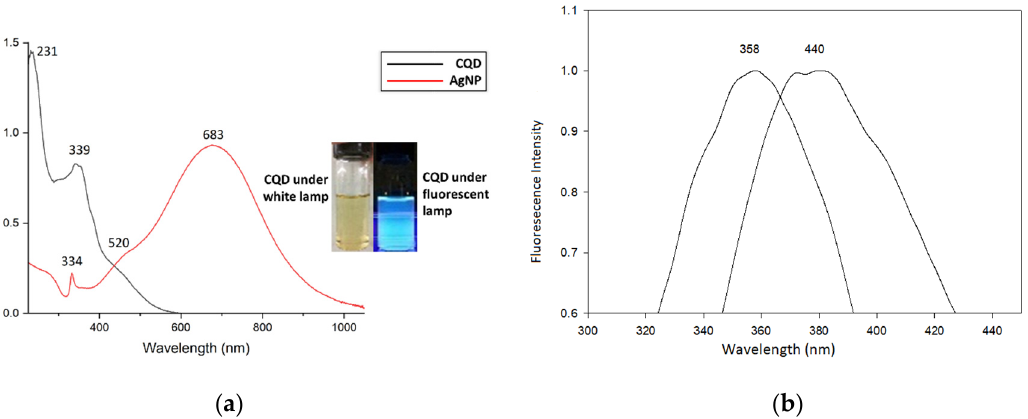
( d ) Figure 5. XPS spectrum ( a ) and high-resolution XPS spectrum of ( b ) C1s, ( c ) N1s, and ( d ) O1s for CDs. In Figure 6a, the optical properties of the prepared CQDs have absorption bands at 231 and 339 nm (black line). The first characteristic absorption peak, at 231 nm, belongs to the C=C bond p–p* transition. The peak at 339 nm stands for the n–p* transition, which depends on the emission trap formation and excitation surface states that facilitate fluo- rescence enhancement [29]. Meanwhile, the AgNP shows three absorption peaks (red